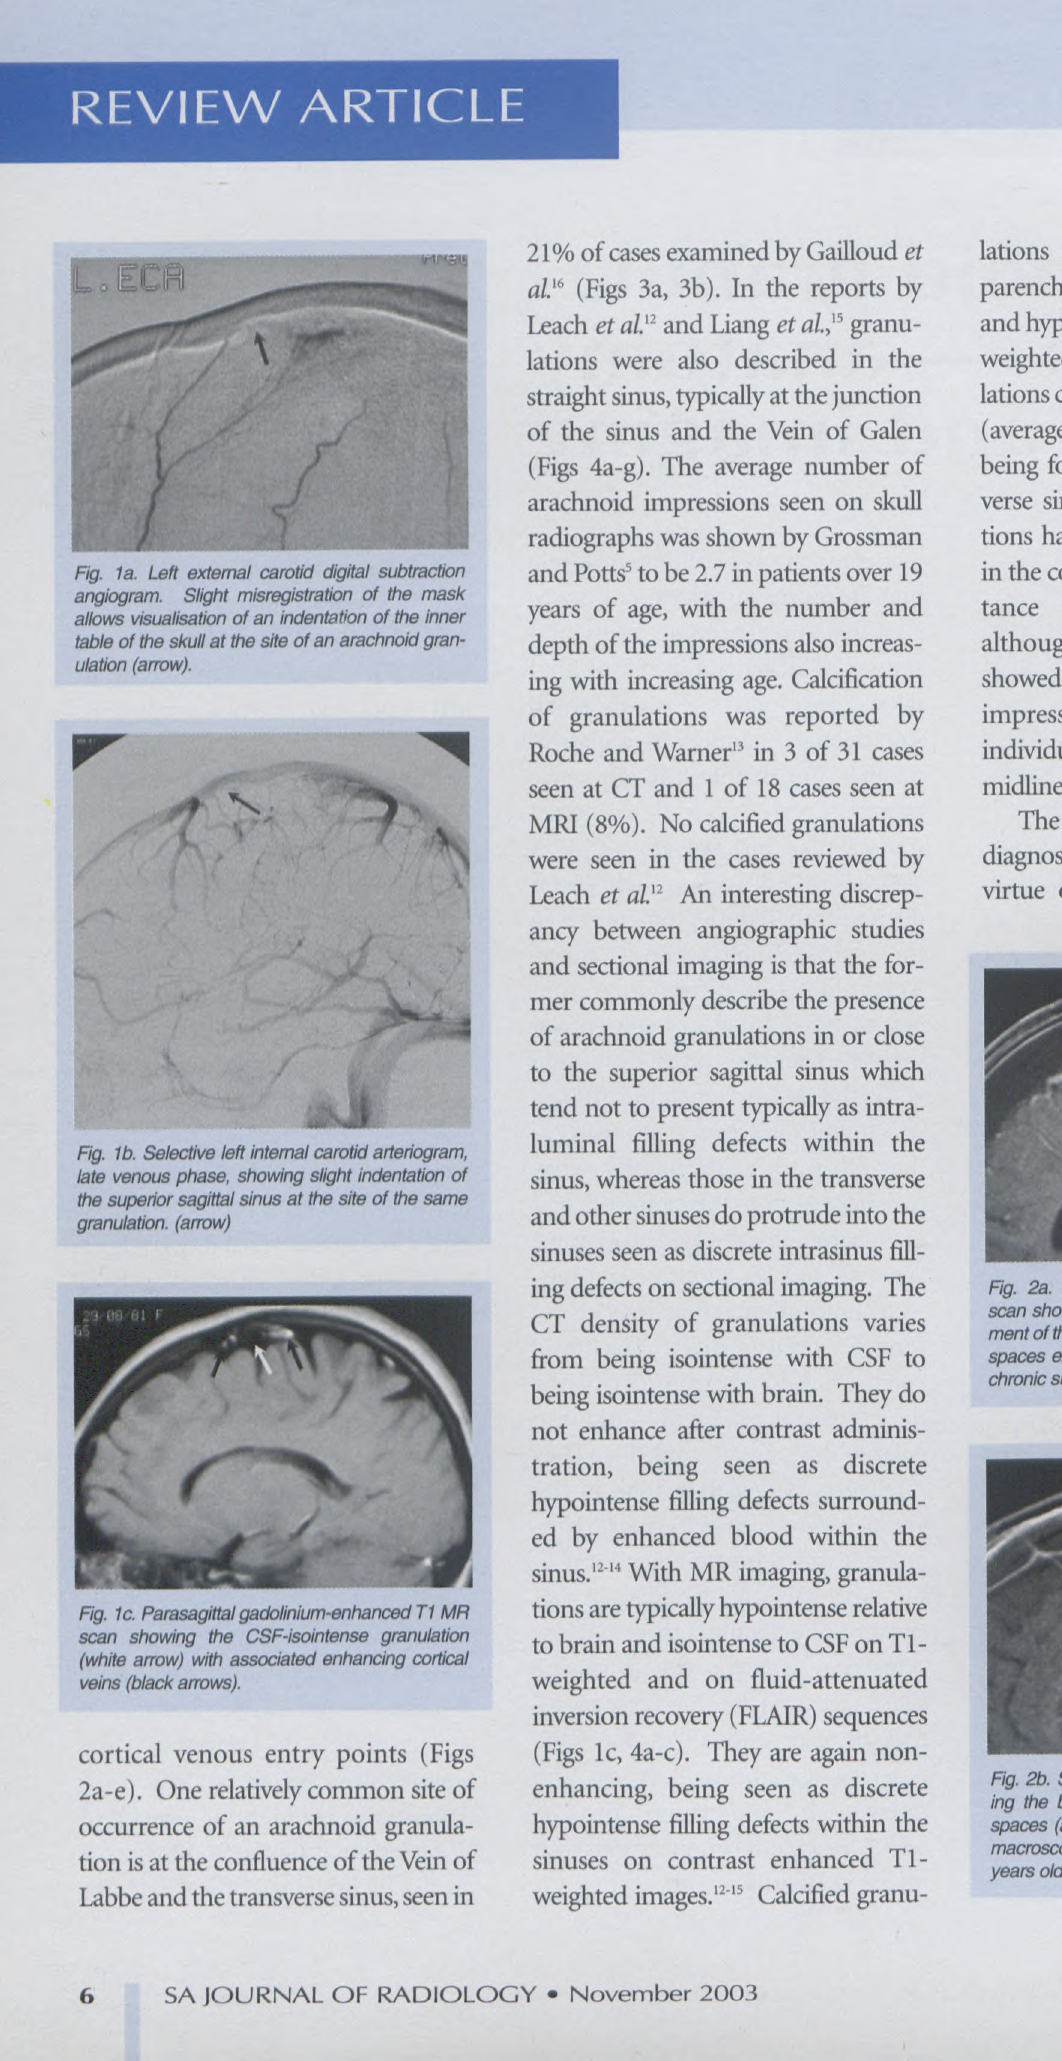
Fig. te. Parasagittal gadolinium-enhanced Tt MR scan showing the CSF-isointense granulation (white arrow) with associated enhancing conical veins (black arrows).